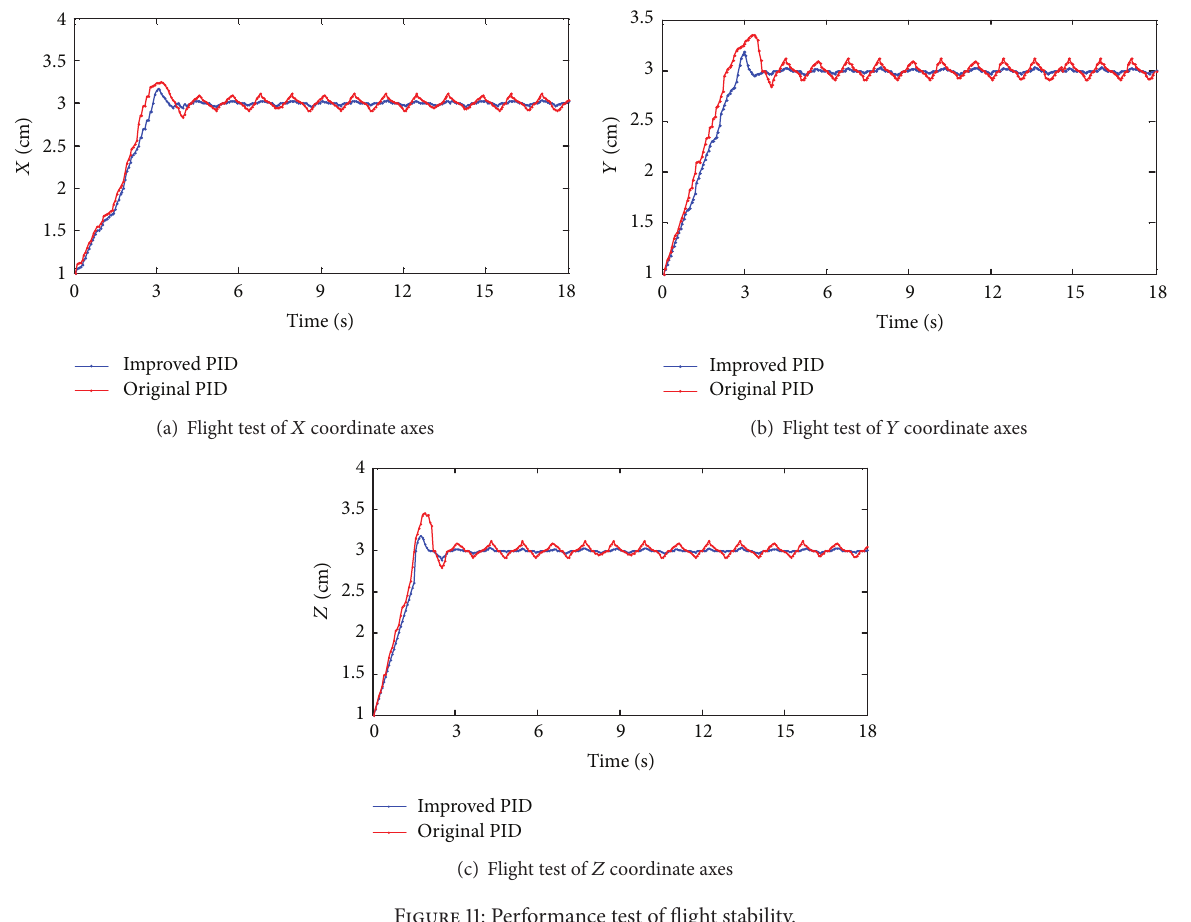
Figure 11: Performance test of flight stability.